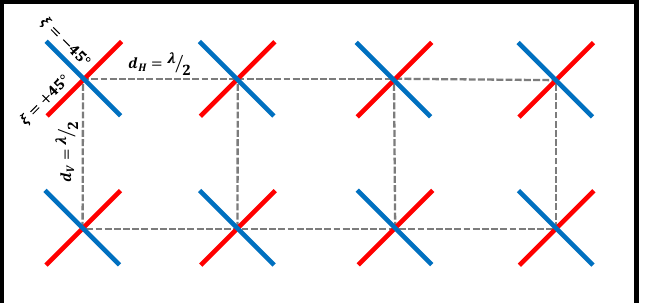
Figure 2. Uniform Planar Array with cross-polarized antenna elements. N ty = 4, N tz =